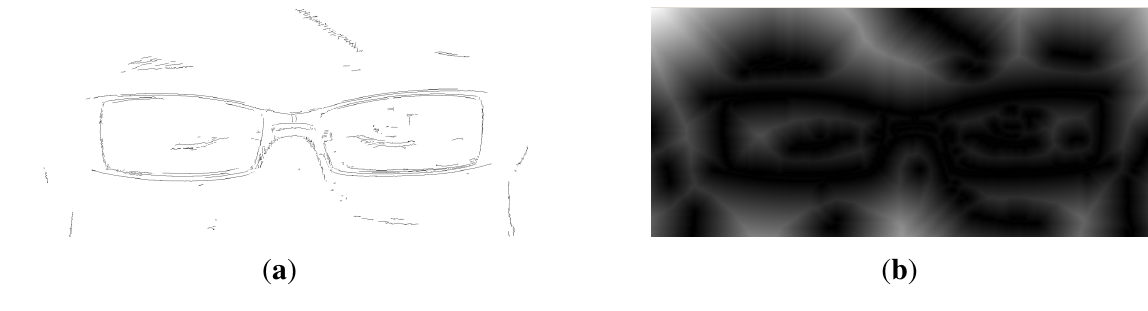
Figure 4. Edge and Distance transform images. ( a ) Canny edge detection; ( b ) distance transform.